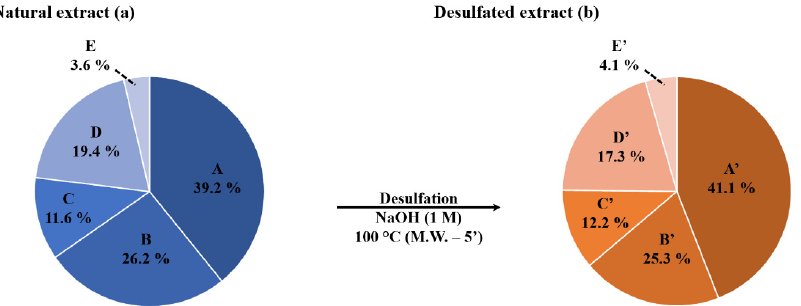
Figure 4. Mass spectrometry qualitative and quantitative analysis of the ( a ) natural and ( b ) desul- fated saponin extracts: the saponin relative proportions (%) correspond to the molar proportions in the natural and modified